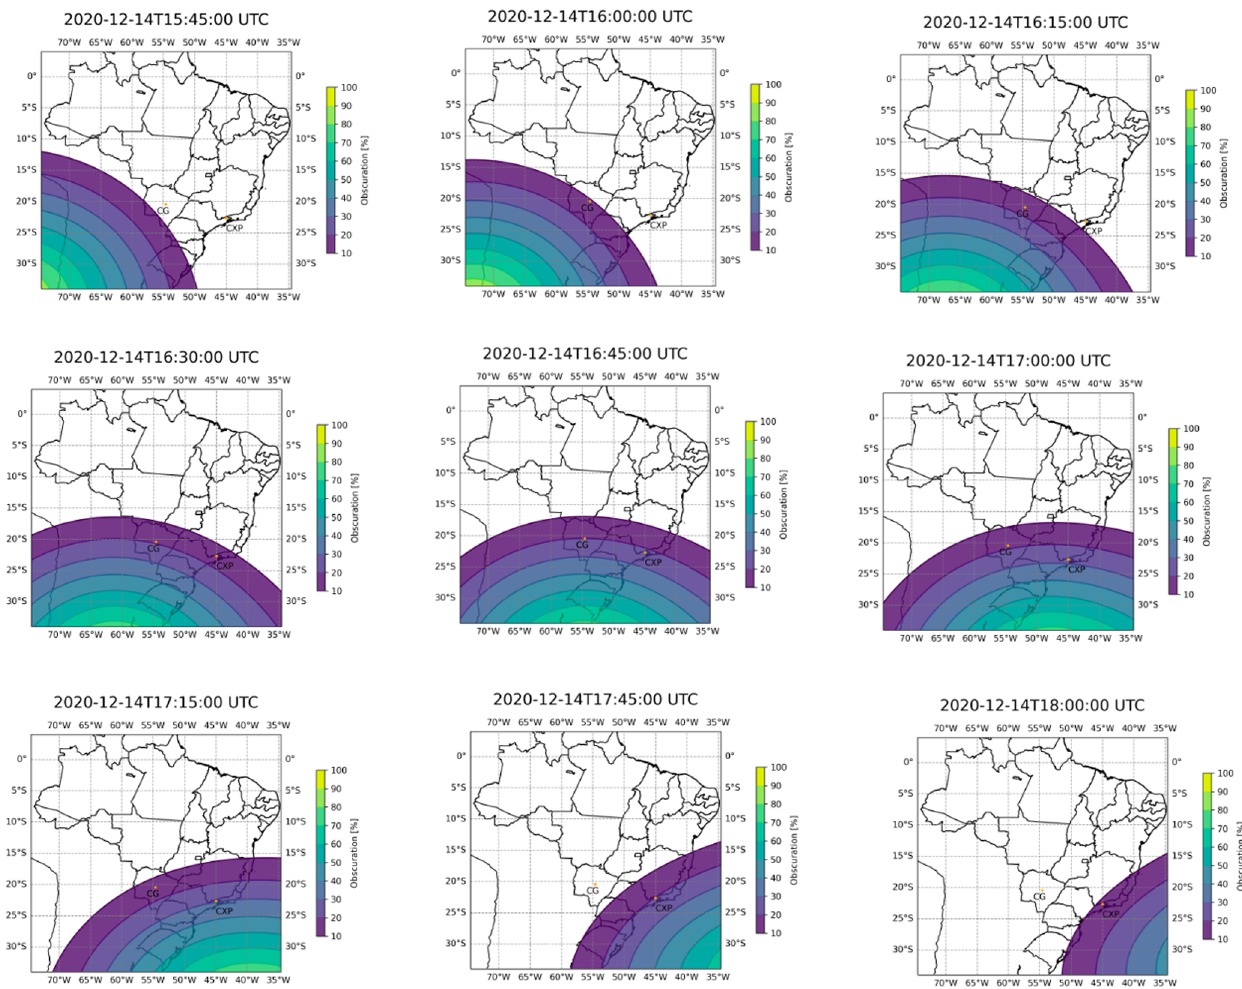
Figure 1. Eclipse obscuration mask at 250km height between 15:45 and 18:00UT for every 15min on 14 December 2020. The contour colors are obscuration varying from 10% (purple) to 100% (yellow). CG and CXP are marked in these maps, referring to the Digisonde